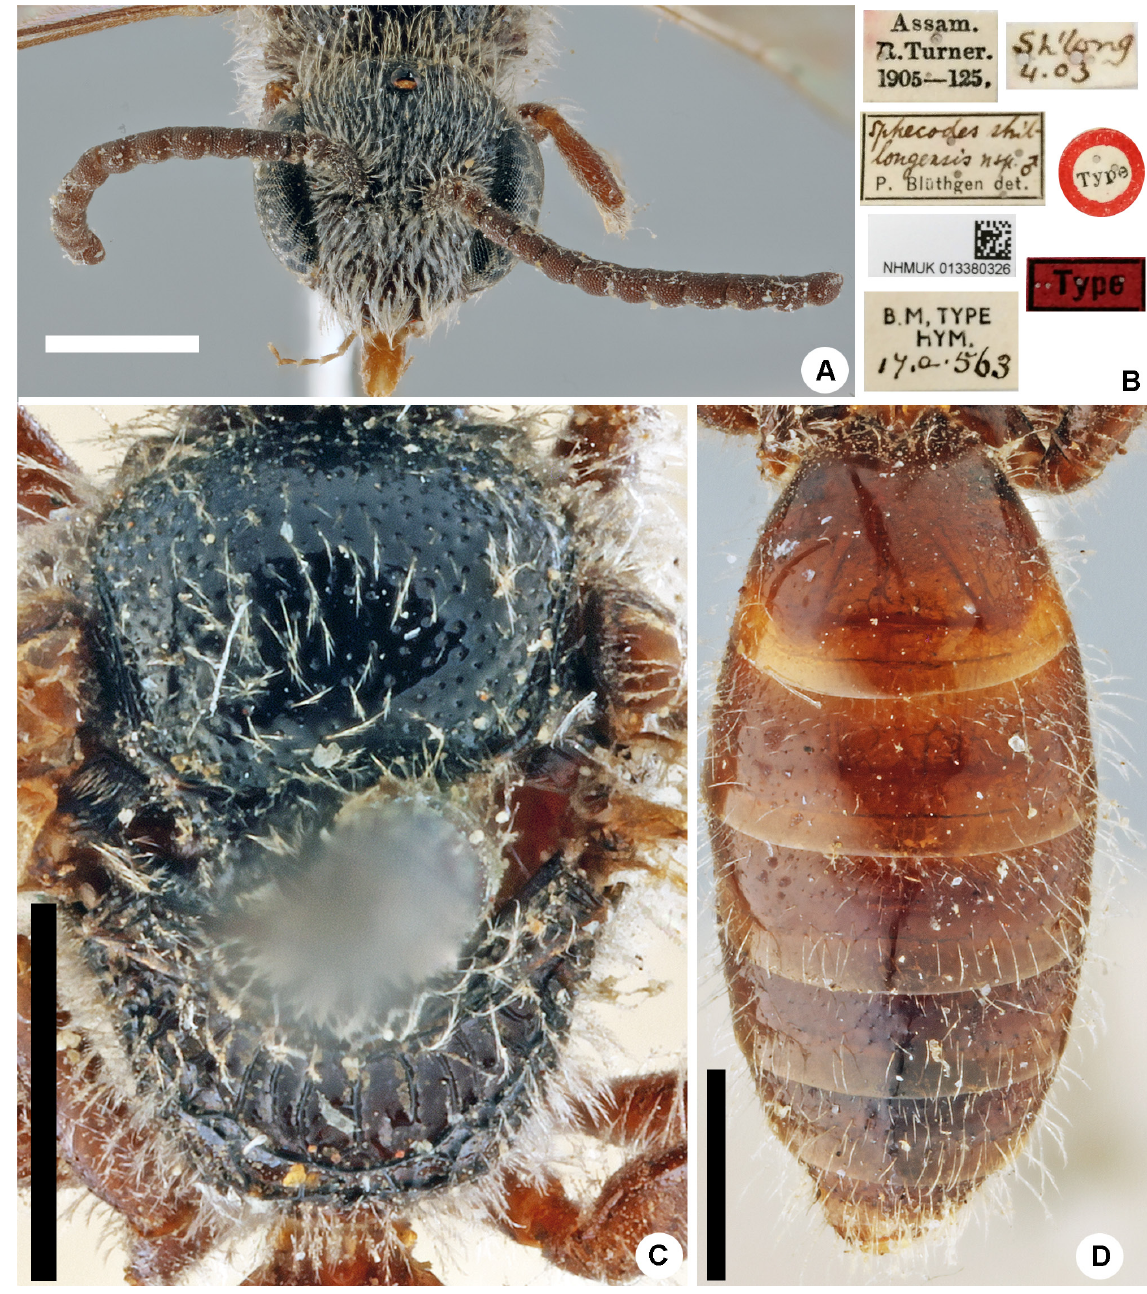
Fig. 17. Sphecodes shillongensis Blüthgen, 1927. Holotype, ♂ (NHMUK 013380326). A . Head in frontal view. B . Labels. C . Mesosoma in dorsal view. D . Metasoma in dorsal view. Scale bars = 0.5